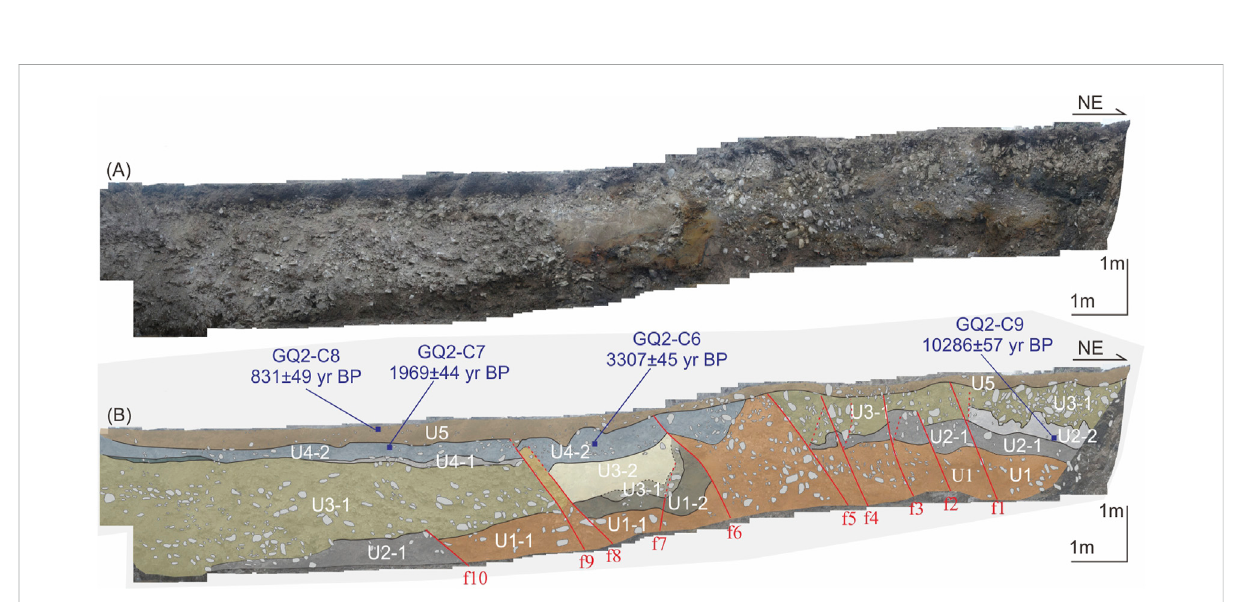
FIGURE 9 Photomosaic (A) and interpretation map (B) of the western wall of trench